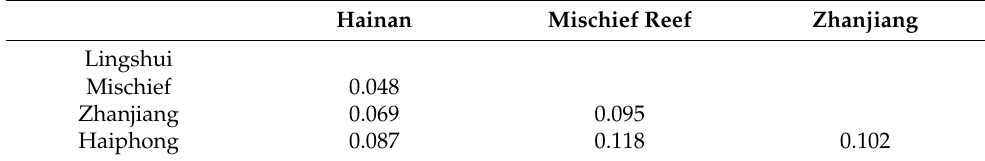
Table 2. Fixation index ( F ST ) between different populations.